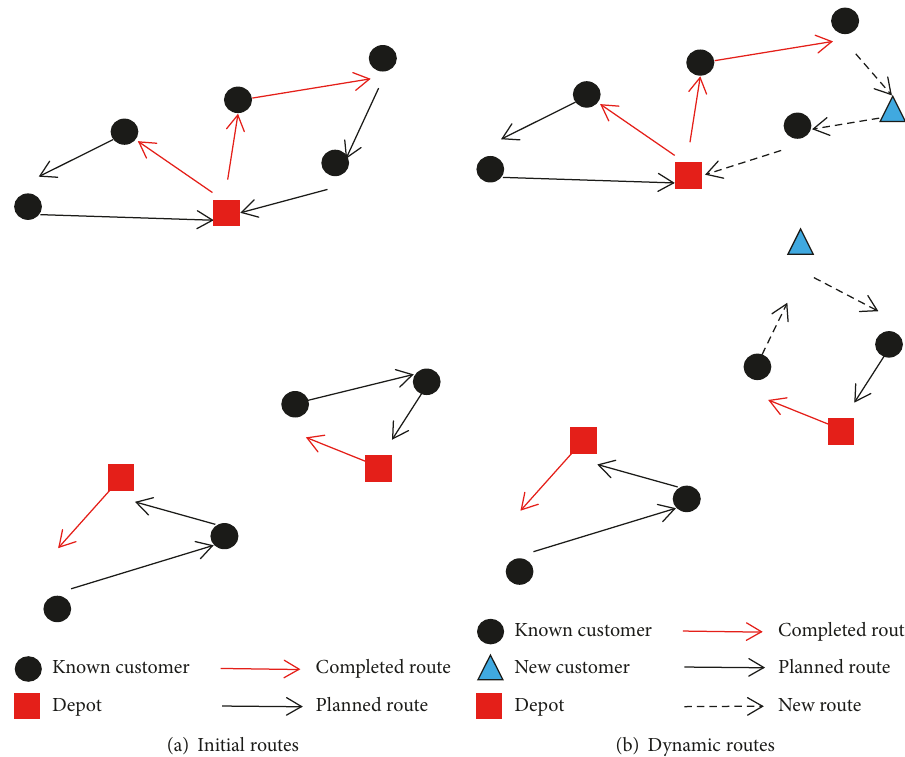
Figure 1: An example of DMDVRP with three